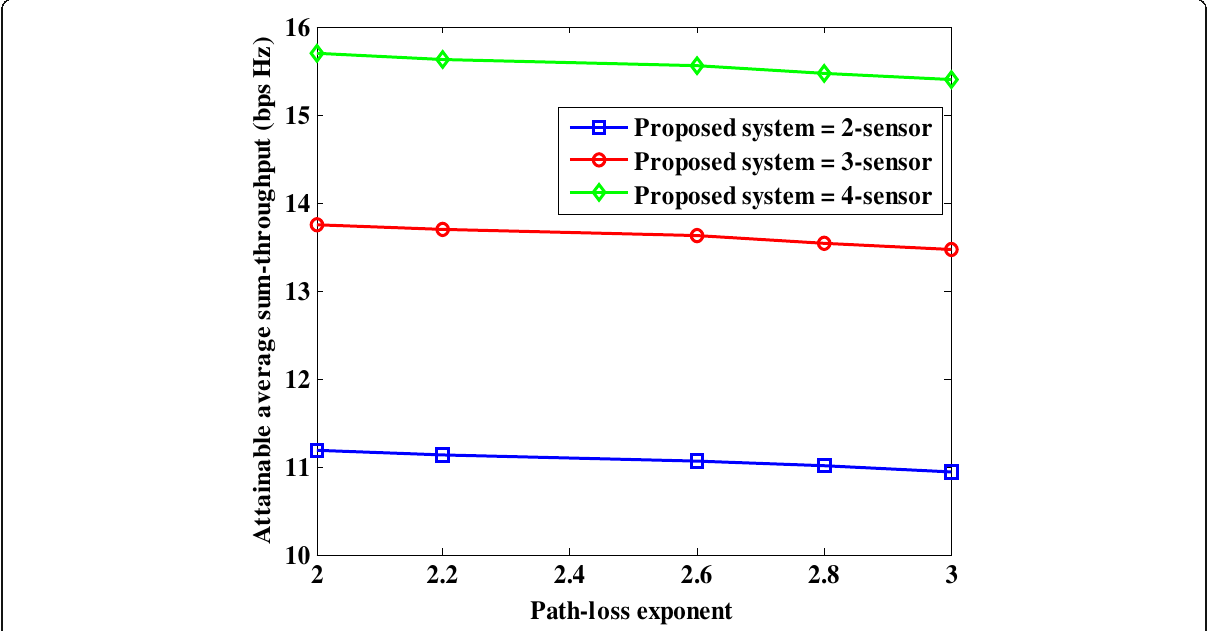
Fig. 5 Attainable average sum-throughput versus path-loss exponent